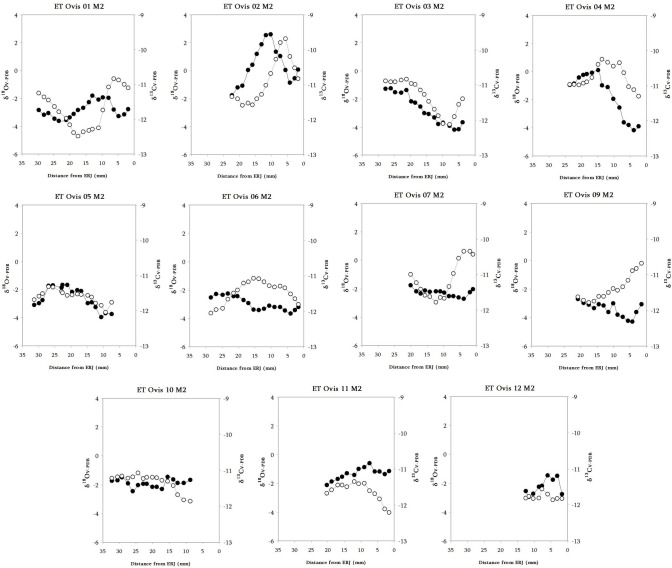
Results from the sequential analysis of oxygen (δ18OV-PDB, white circles) and carbon (δ13CV-PDB, black circles) isotope composition in sampled enamel bioapatite from Cova de Els Trocs sheep lower second molars (M2).